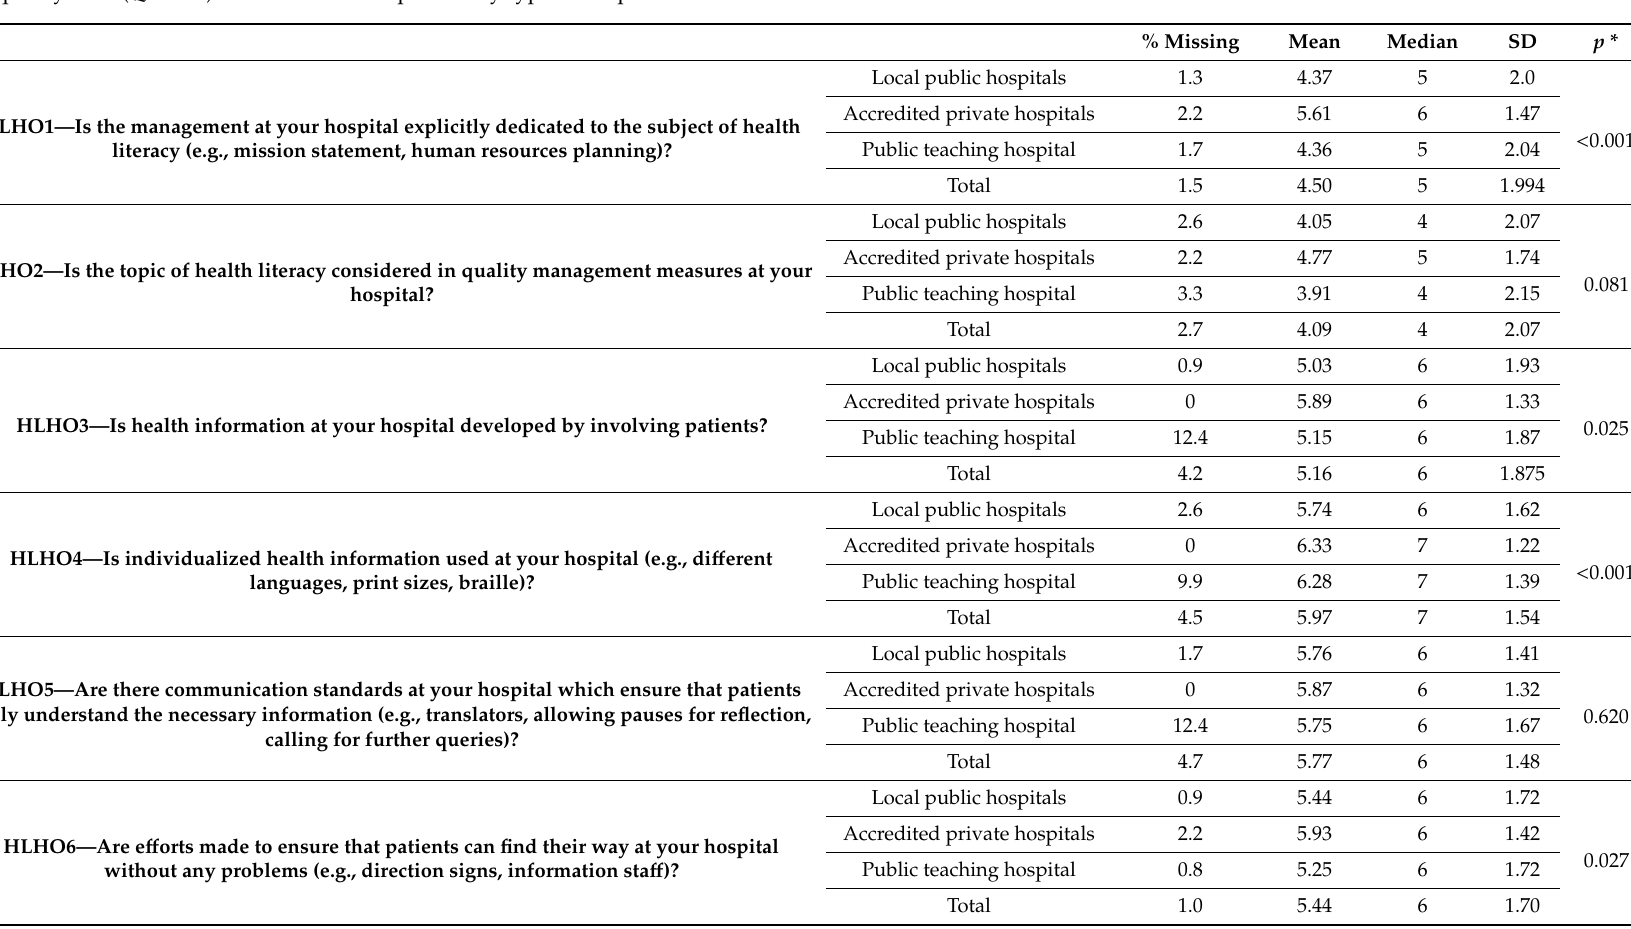
Table 3. Descriptive analysis of the items of the 10-item questionnaire for Health-Literate Healthcare Organization (HLHO-10), the HLHO score, and the perceived quality item (QUAL1) for the whole sample and by type of hospital.